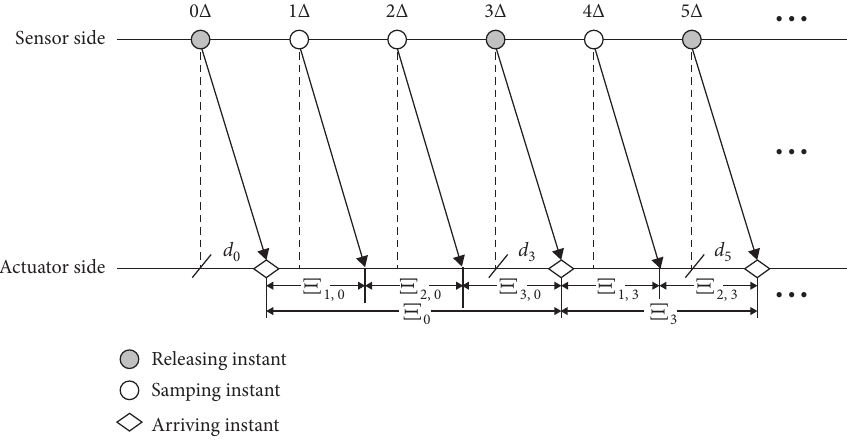
Figure 3: An example of timing diagram for AETM.